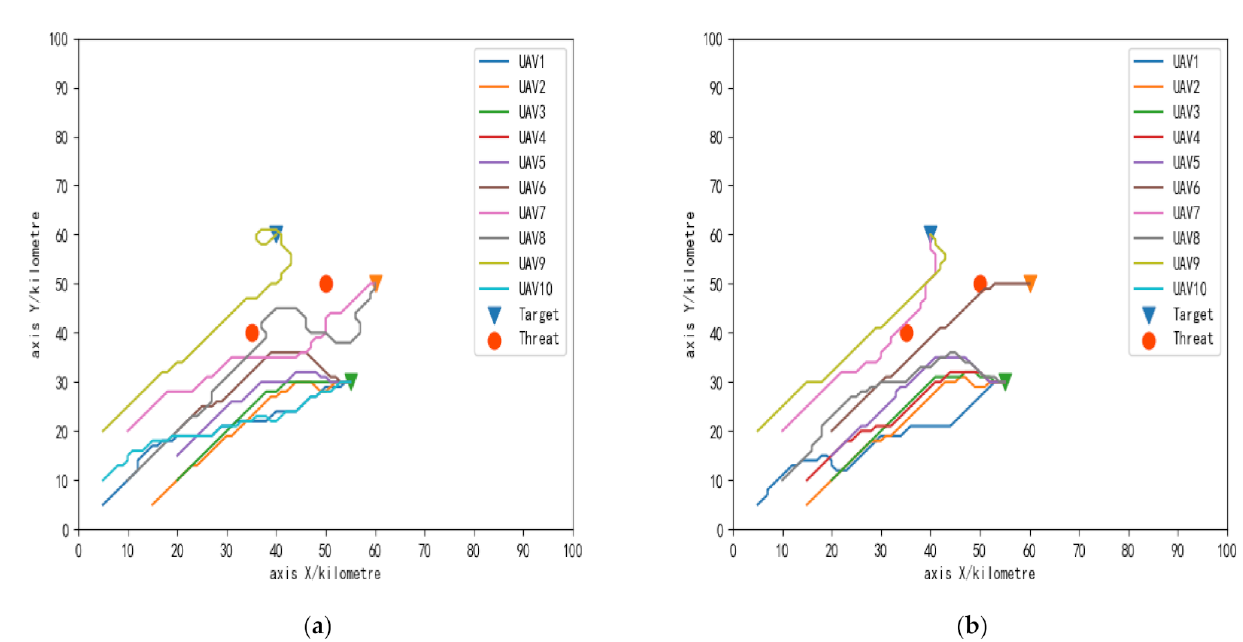
Figure 3. Experimental results of multi-unmanned aerial vehicle cooperative target search. ( a ) is the result of UAV target search using CDPIO algorithm; ( b ) is the result of UAV target search using PIO